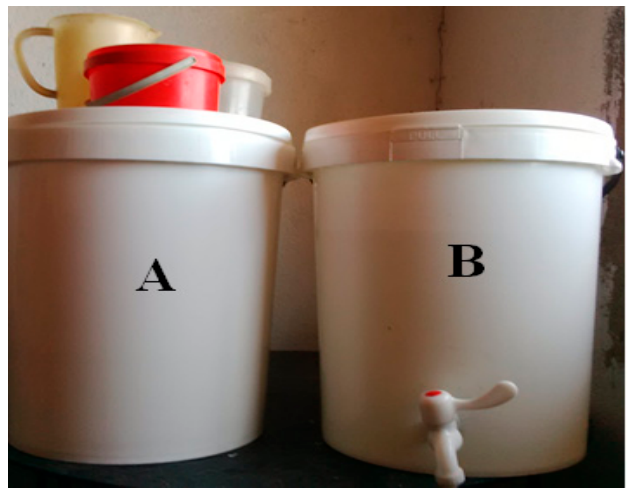
Figure 4. Regular ( A ) and improved ( B ) storage containers supplied to households of Makwane Village.